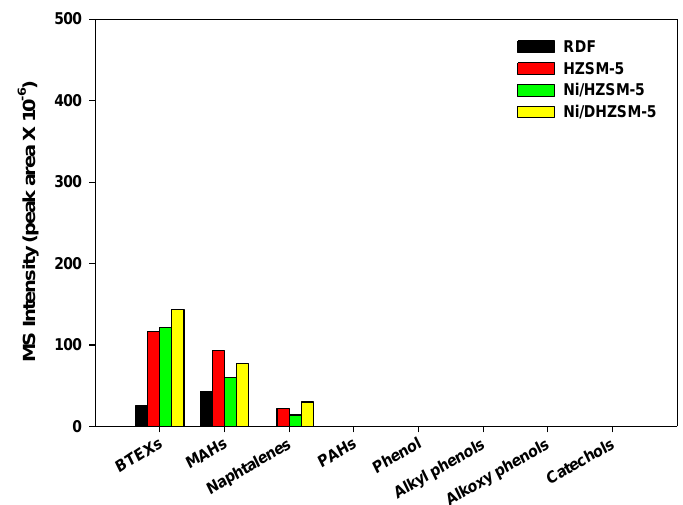
Figure 5. Summed MS peak areas for each chemical groups obtained from the CP of RDF over different catalysts. (BTEXs: benzene, toluene, ethylbenzene, and xylenes; MAHs; other mono-aromatic hydrocarbons; PAHs; Other poly-aromatic hydrocarbons).